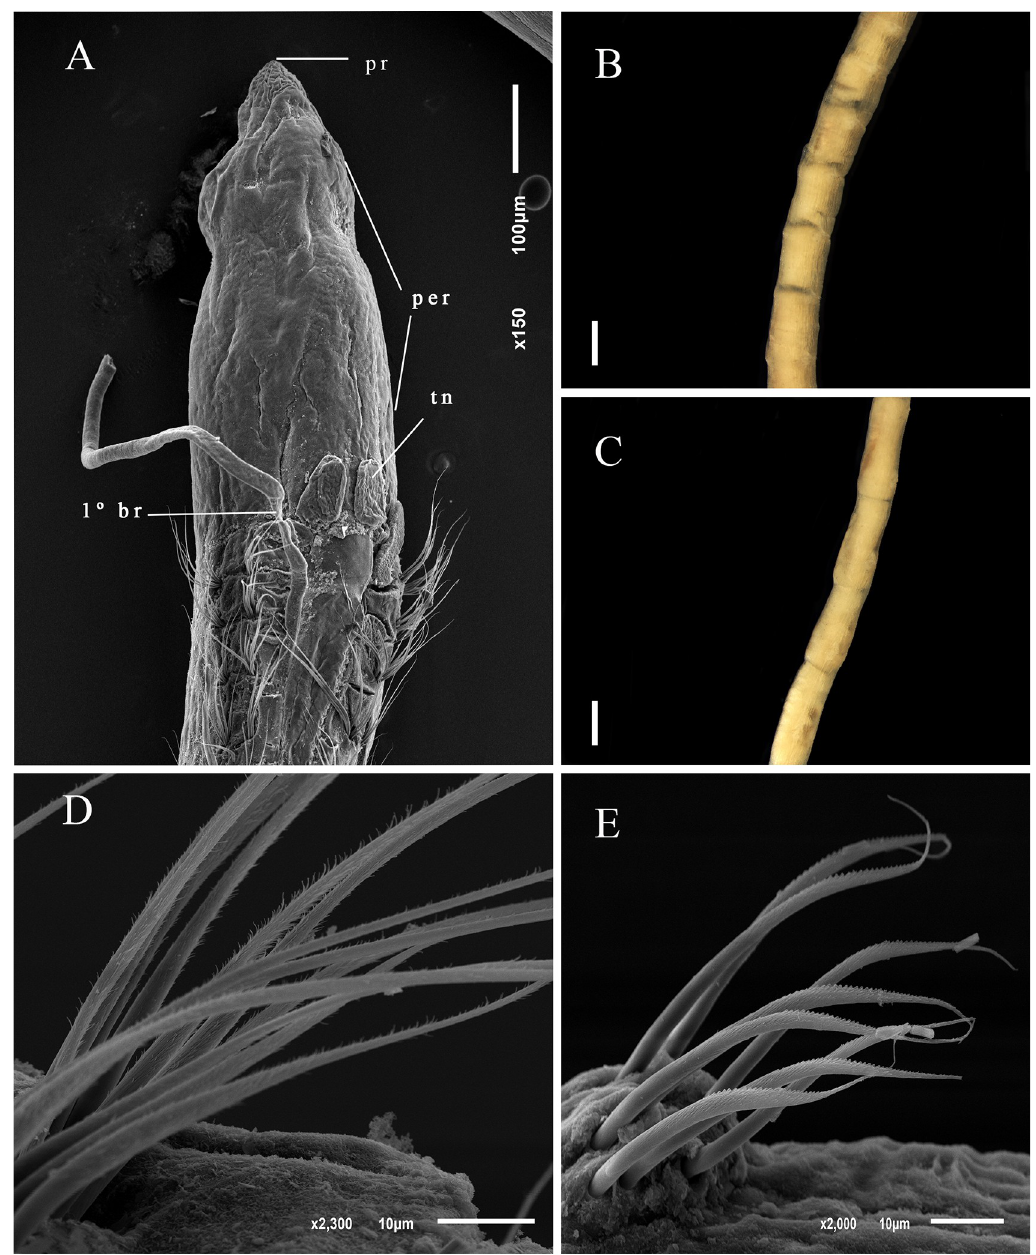
denticulated. B–C (MNRJP-003000). Scale bars: 2 mm (B and C). Type locality. Atlantic Ocean: Campos Basin (Brazil). Habitat. Fine sediments composed of silt and clay, between 41 to 352 m deep. Distribution. Presently known only from Atlantic Ocean: Campos Basin (Brazil). Methyl Green. No pattern, but prominent staining on the thoracic